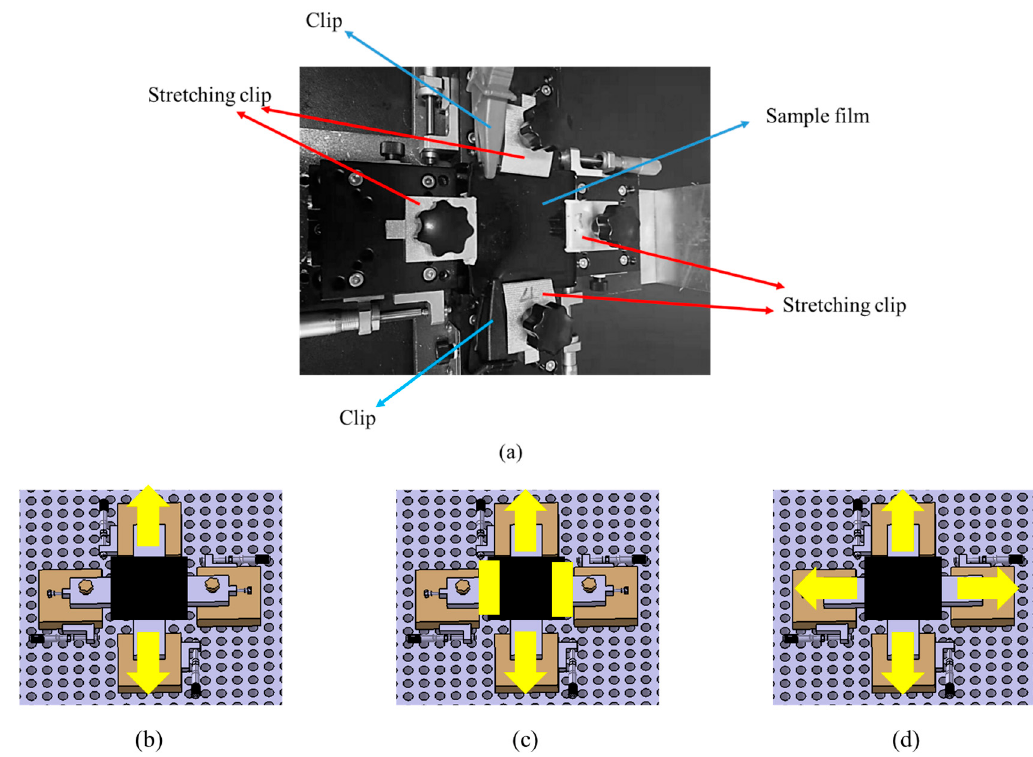
Figure 4. ( a ) Biaxial stretching fixture. ( b ) First stretching method. ( c ) Second stretching method. ( d ) Third stretching method.